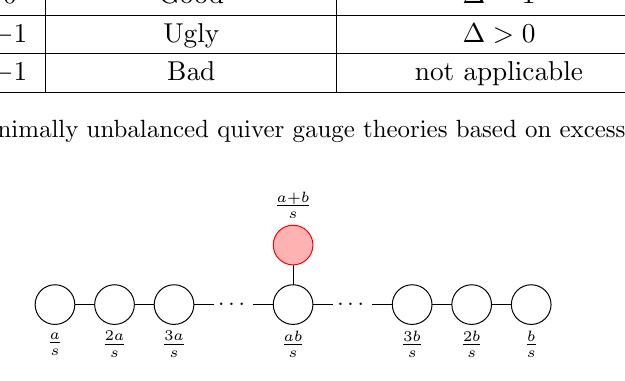
Figure 1 . Generic quiver with G = SU( n ) global symmetry, with n = a + b , where a; b 2 N and s is the greatest common divisor of a and b . The excess of the bottom nodes is e = 0. The excess of the top node is e = ( ab (cid:0) 2 a (cid:0) 2 b ) =s . We are interested in the subset of quivers with ( ab (cid:0) 2 a (cid:0) 2 b ) =s 6 =